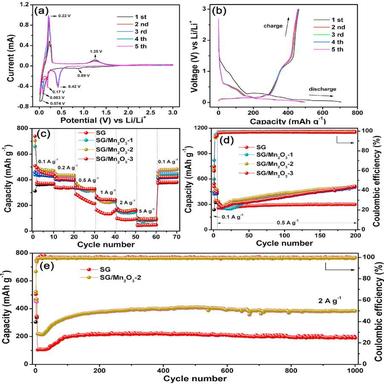
(a, b) EIS curves of SG and SG/Mn2O3-2 electrode before and after cycling. (c) Corresponding fitted equivalent circuit.